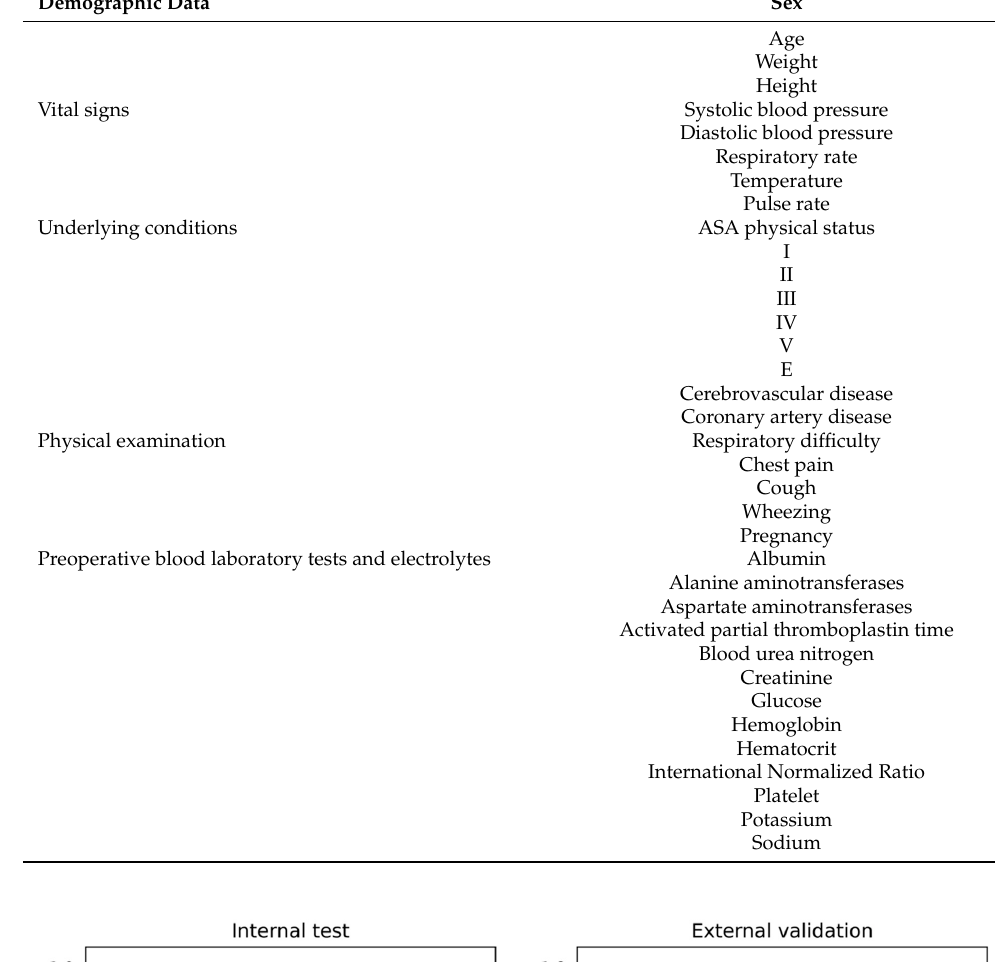
Table 1. Preoperative variables used in the prediction model.